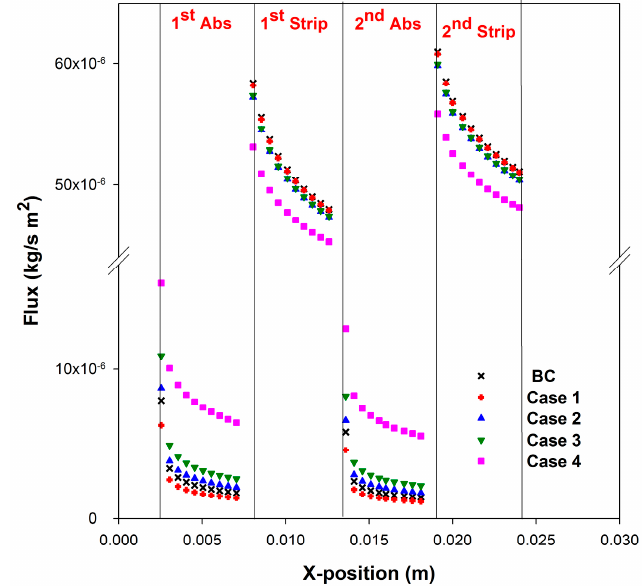
Figure 10. Effects of liquid velocity and diffusivity on transmembrane CO 2 mass flux in CE-HASMC.